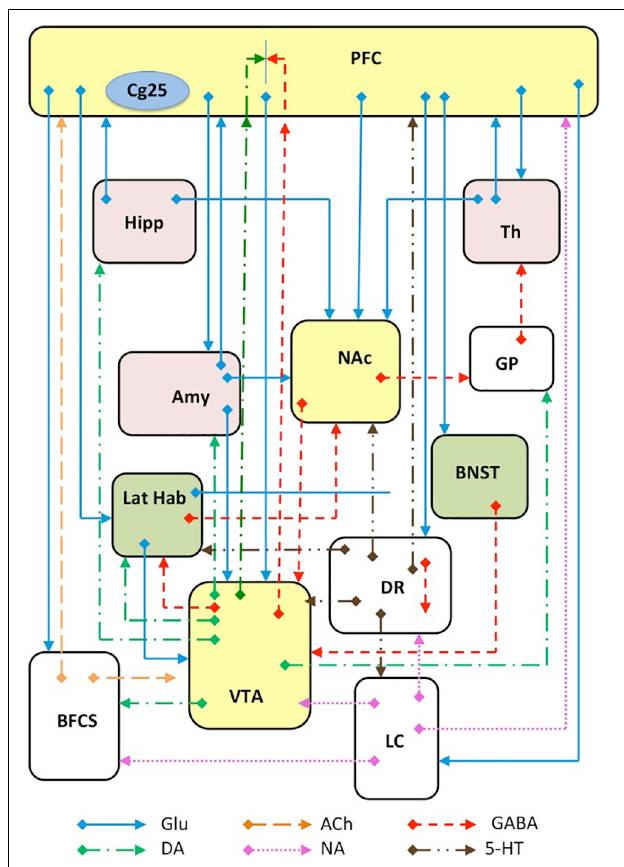
FIGURE 3 | Schematic representation of several major glutamatergic input pathways on mammalian brain nuclei where ketamine might interact with glutamate transmission by interacting with NMDA and/or AMPA receptors. Abbreviation: PFC, prefrontal cortex; Cg25, subgenual cingulate region; Th, thalamus; Hipp, hippocampus; LHb, lateral habenula; Amy, amygdala; VTA, ventral tegmental area; DR, dorsal raphe; BFCS, basal forebrain cholinergic system; LC, locus coeruleus; GP, glubus pallidus. Glutamate (Glu), dopamine (DA), GABA, acetylcholine (Ach), norepinephrine (NA) and serotonin (5-HT) neurons and axons are